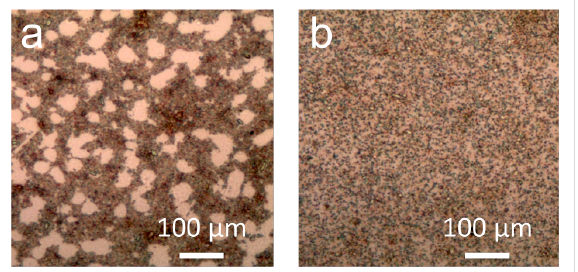
Figure 4: Optical images of GO-covered AgNCs prepared with proce- dure A (a) and B (b).